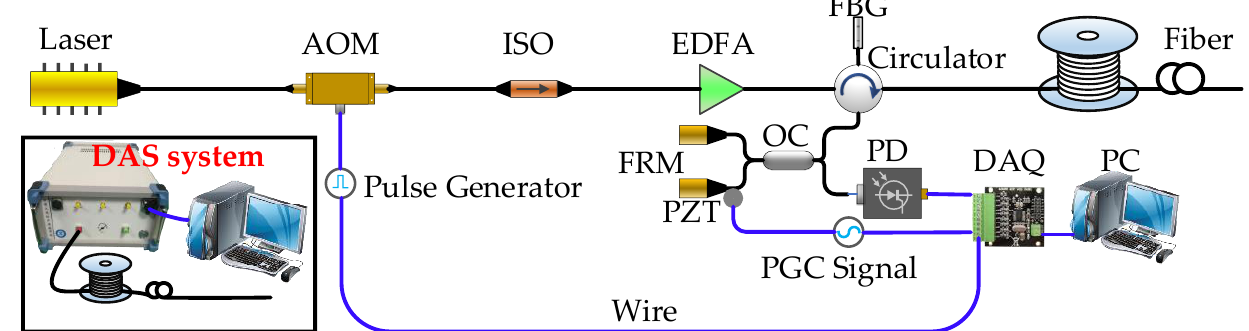
Figure 5. The structure of the DAS system based on the PGC algorithm (AOM: acousto-optic modulator; ISO: isolator; EDFA: erbium-doped optical fiber amplifier; FBG: fiber Bragg grating; OC: optical coupler; DAQ: data acquisition card; FRM: faraday rotation mirror; PZT: piezoelectric ceramic transducer; PD: photo detector; PC: personal computer).